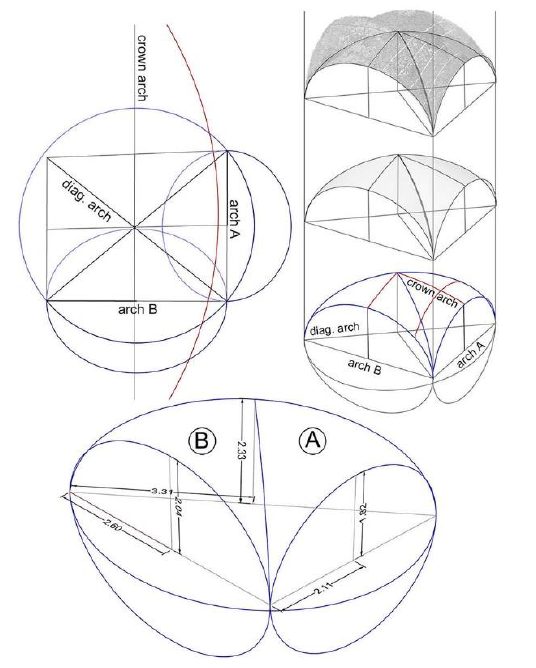
Figure 5. Geometric hypothesis: ellipsoidal surface portions bounded by lateral and diagonal arches 6. DATA FILTERING: CURVES AND REGRESSION QUADRICS THAT BEST FIT REAL ARCHES AND SURFACES